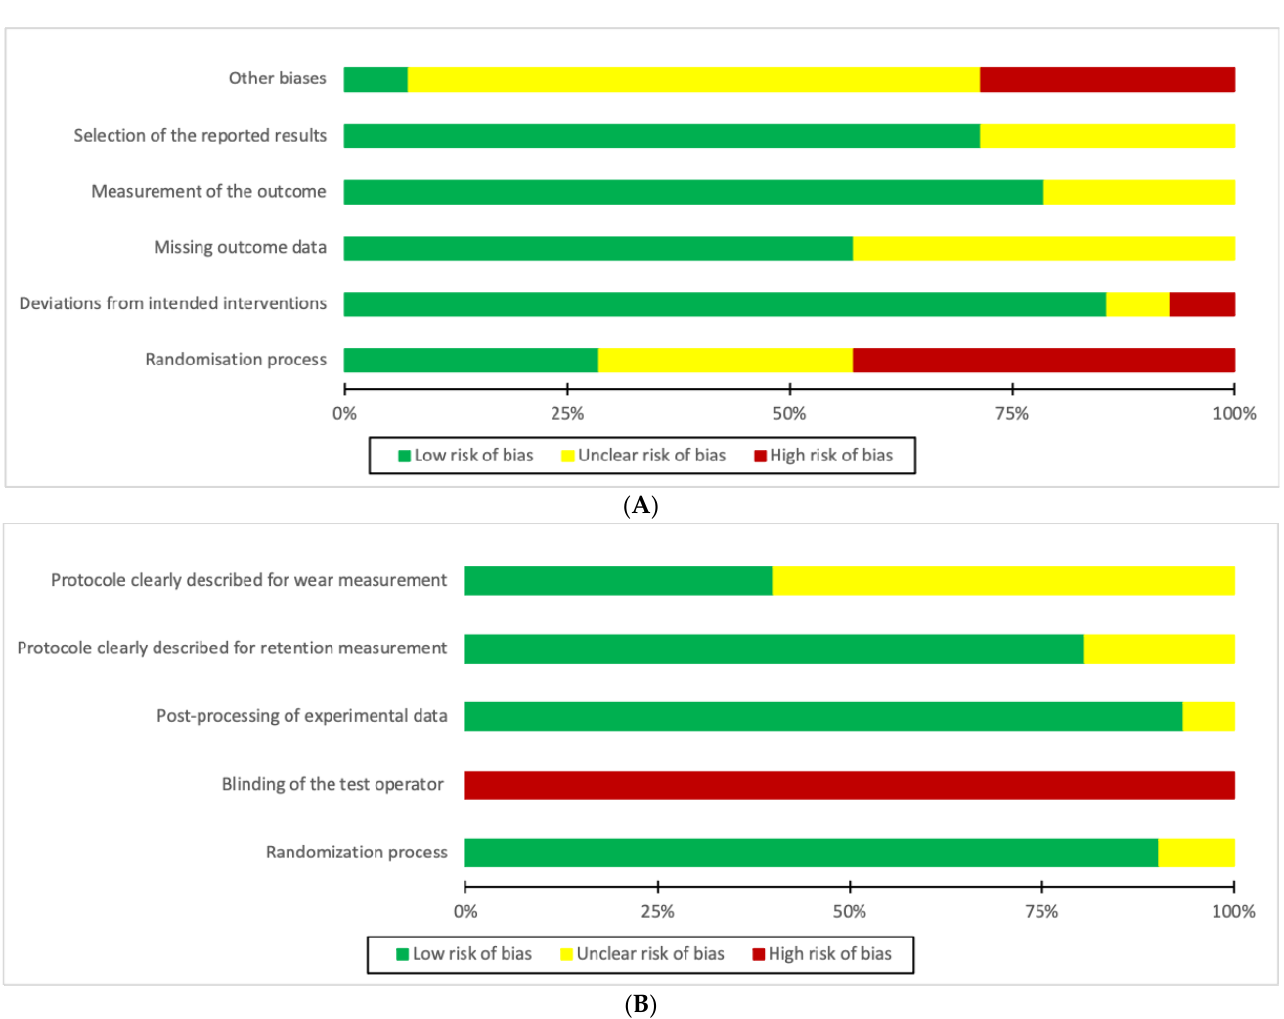
Figure 3. Risk of bias graph: author’s assessment of each risk of bias item in proportions for all clinical ( A ) and in vitro studies ( B ).